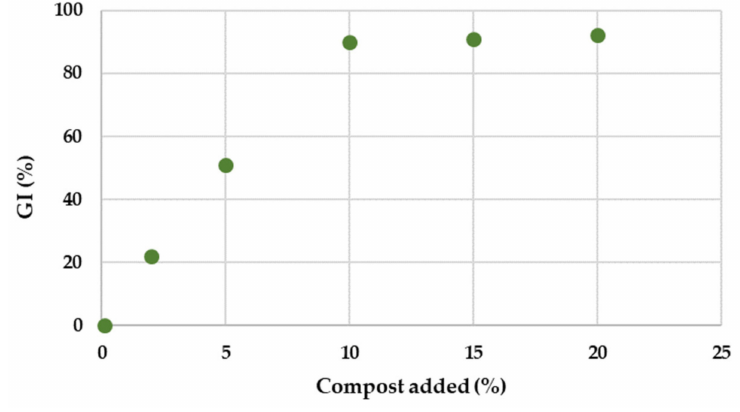
Figure 5. Variation of Germination Index (GI%) at increasing compost addition.